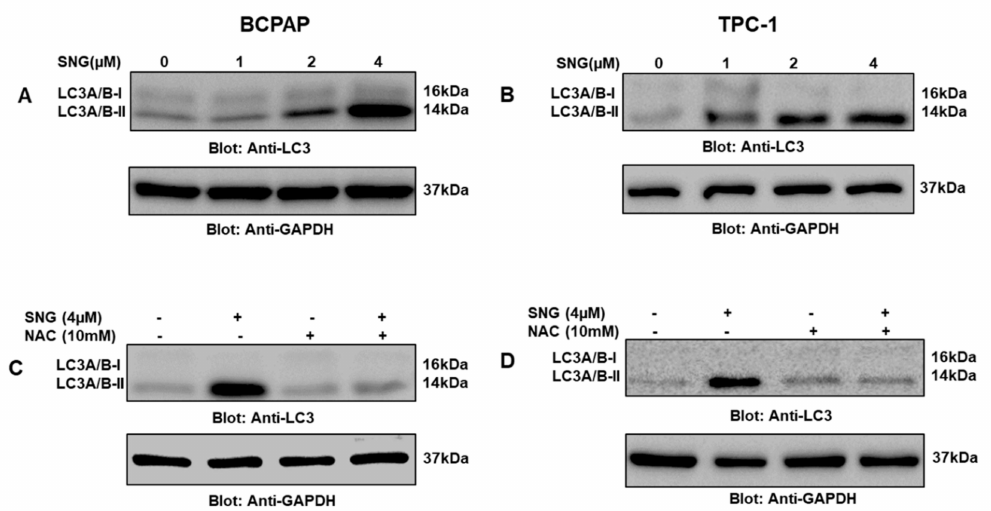
Figure 6. Induction of autophagy in PTC cells treated with SNG. BCPAP ( A ) and TPC-1 ( B ) cells were treated with increasing doses of SNG for 4 h, as indicated. After cell lysis, equal amounts of proteins were separated by SDS–PAGE, transferred to a PVDF membrane, and immunoblotted with antibodies against LC3 and GAPDH. NAC pretreatment of PTC cells prevented SNG-induced LC3 expression. BCPAP ( C ) and TPC-1 ( D ) cells were pretreated with 10 mM NAC and subsequently treated with 4 µ M SNG for 4 h. Cells were lysed, and 50 µ g of proteins separated on SDS-PAGE, transferred to a PVDF membrane, and immunoblotted with antibodies against LC3 and